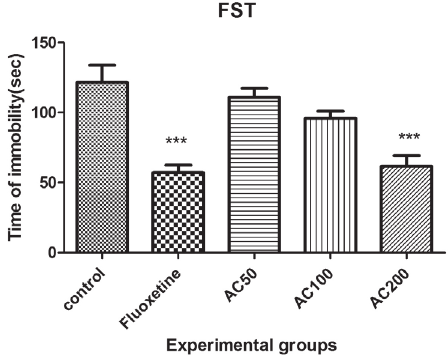
FIGURE 1 - Effect of Adiantum capillus-veneris extract on Immobility Duration in the Forced Swim Test. *** = ( P < 0.001); AC: Adiantum